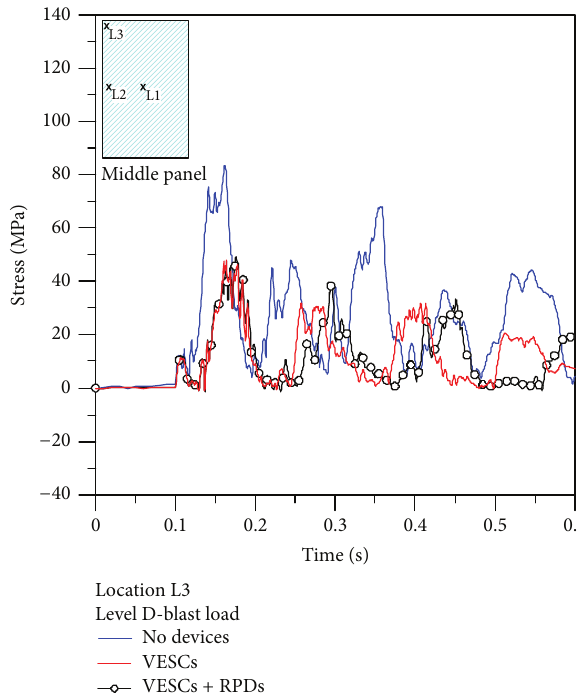
Figure 7: Tensile stresses in the middle glass panel, as a function of time (ABAQUS). Location L1.